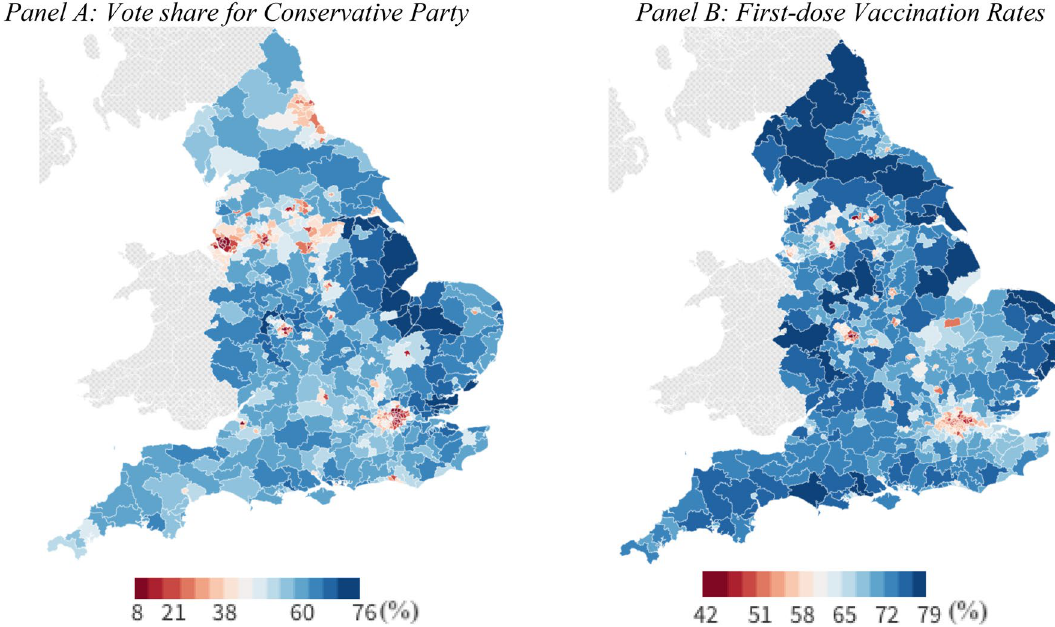
Figure 1. Mapping vote share and vaccination rates across English constituencies. This figure shows the vote share (left-hand side) and vaccination rate (right-hand side), both expressed as percentage points, in different English constituencies. Vaccination rates were calculated by dividing the number of first doses in constituency i by the total population of that constituency and then multiplying this ratio by 100. This figure was created with https:// flour ish.